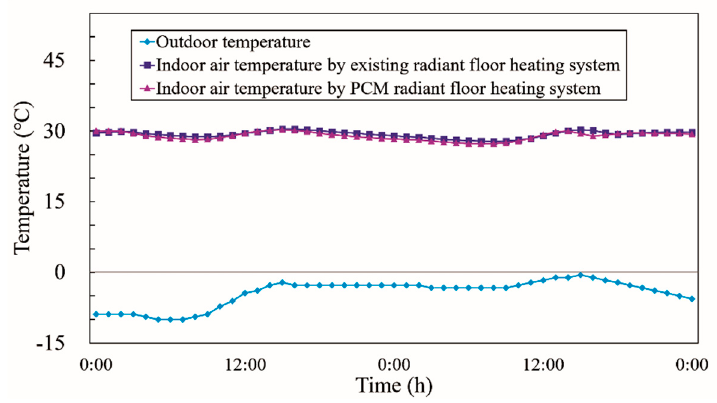
Figure 10. Floor surface temperatures on the second stories of the apartment buildings.